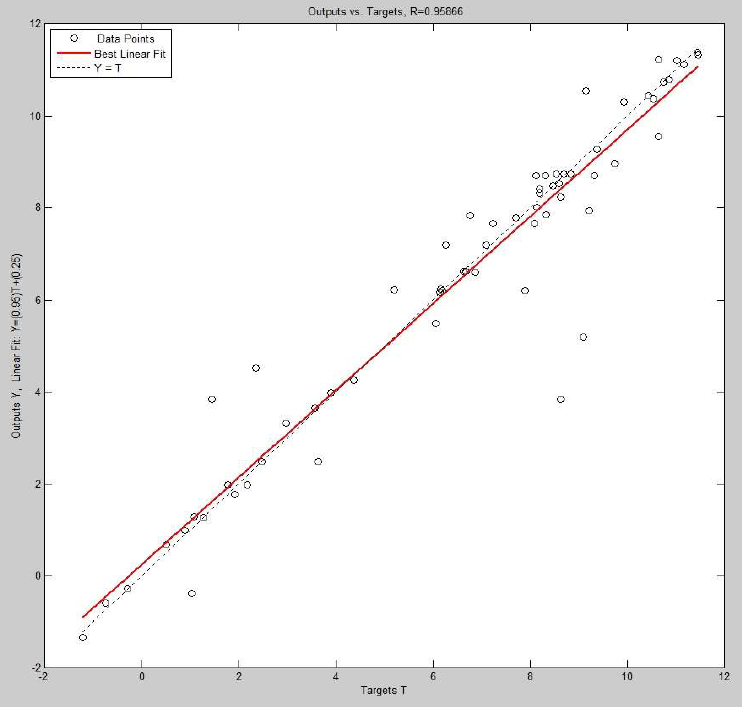
Figure 9. Torque neural network regression. analysis (outputs vs targets).